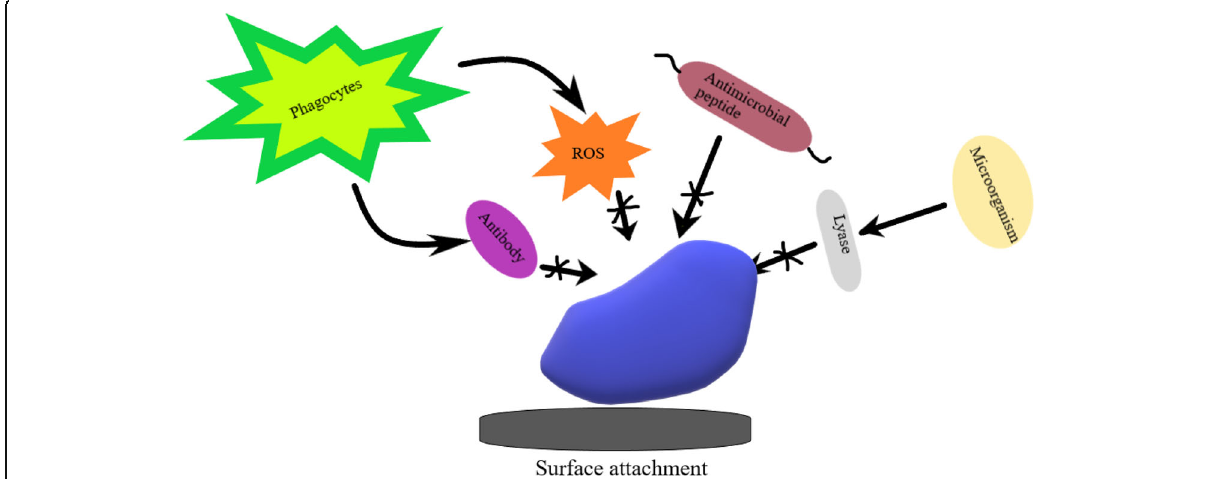
Fig. 4 Bacterial biofilms exhibiting resistance due to modification in the